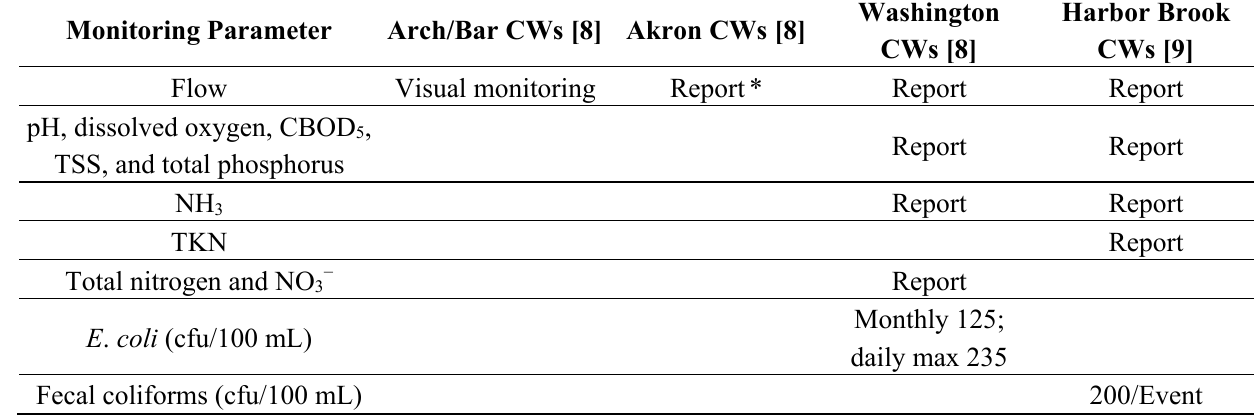
Table 3. Current permit limits for CSO constructed wetland effluent in the US *.